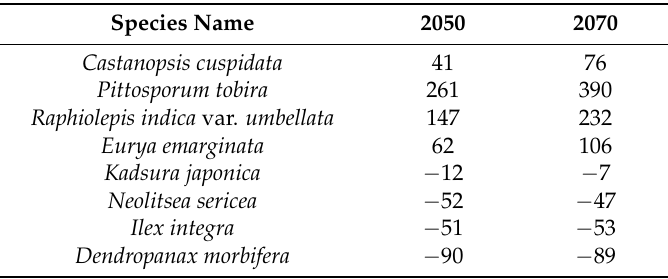
Table 3. Areal changes of the climatic niche of eight plants under climate change. While the first four species ( C. cuspidata to E. emarginata in the first column) showed expansions of suitable habitats under climate changes, the remaining four species ( K. japonica to D. morbifera ) presented contractions of habitats. The unit is %. The numbers show the percent areal changes under climate